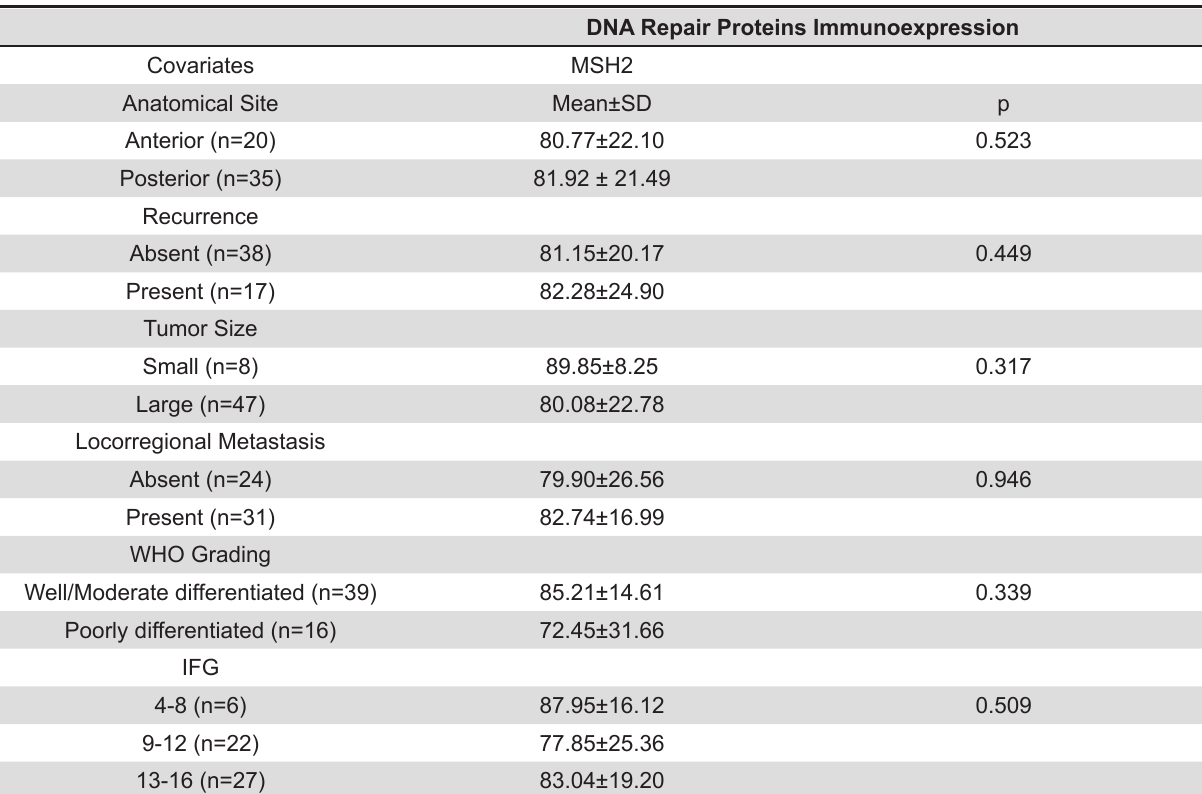
Table 1- Bivariate analysis between the clinicopathologic covariates and the mean values of MSH2 immunohistochemical expression in the head and neck squamous cell carcinoma